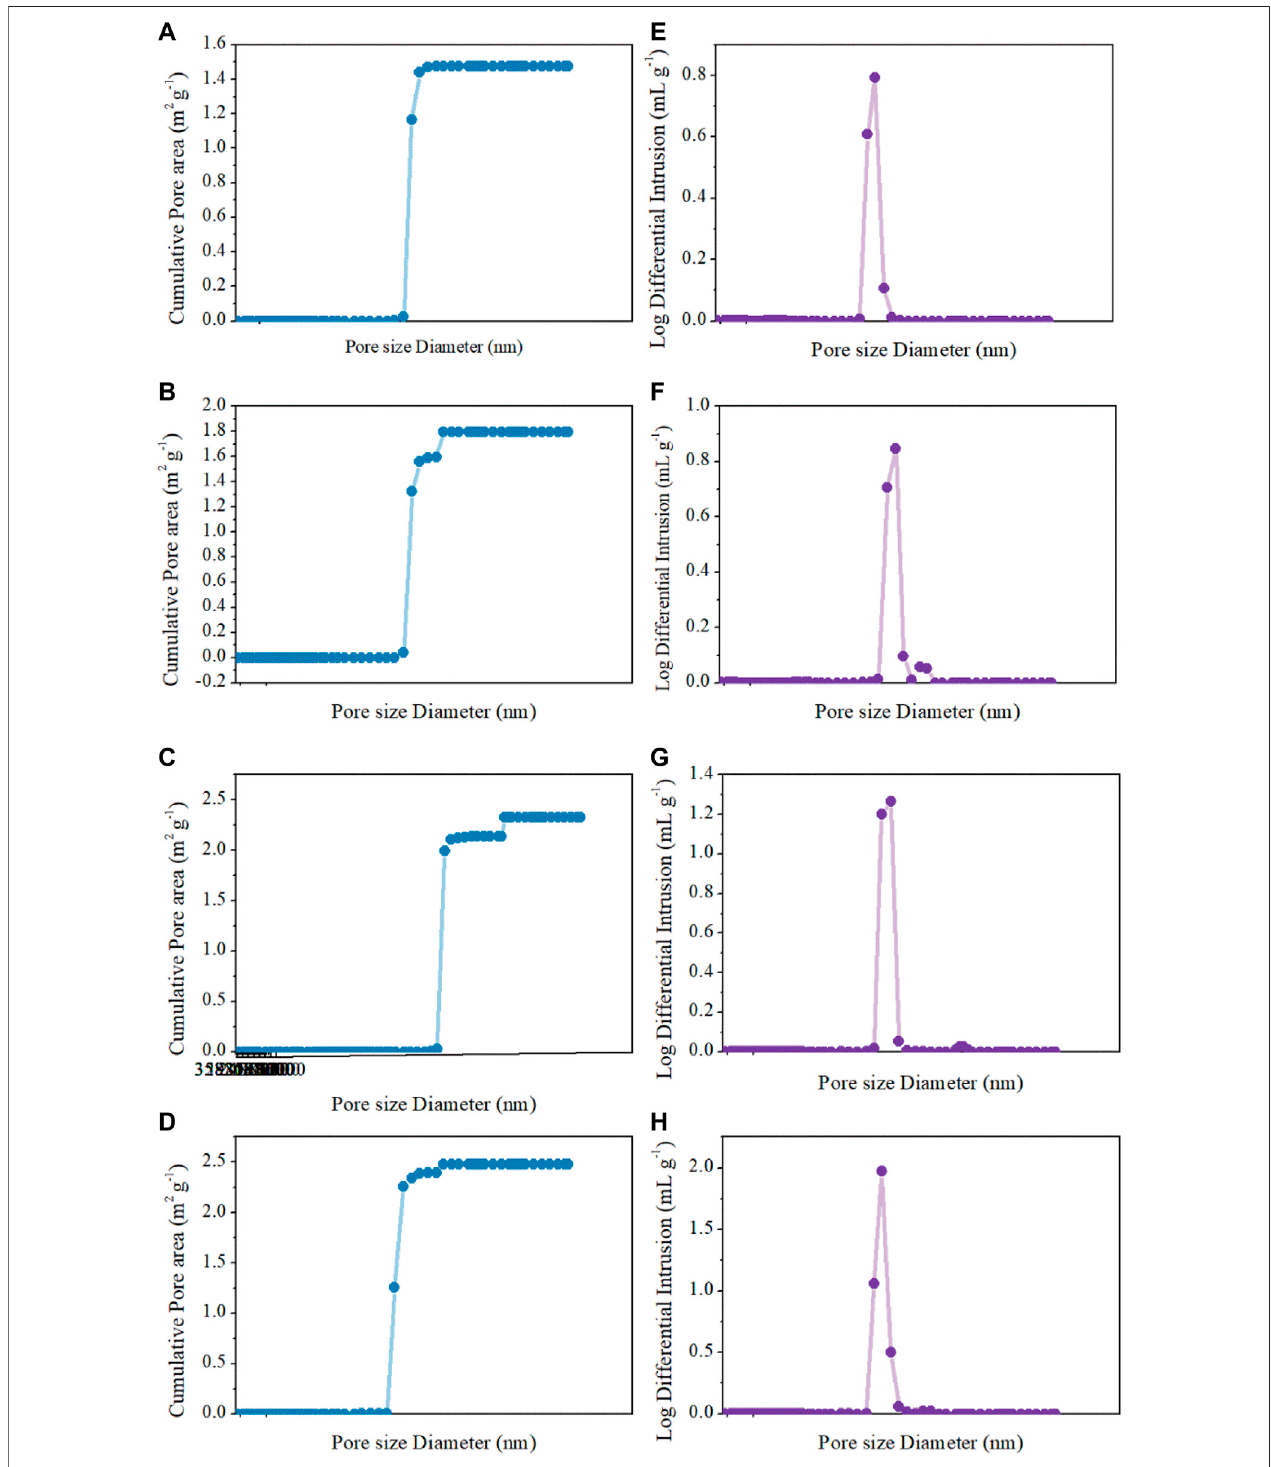
FIGURE 5 | Cumulative pore area and log differential intrusion pore volume of Hg intrusion porosimetry analysis for (A,E) 0wt%, (B,F) 1.5wt%, (C,G) 5wt%, and (D,H) 15wt%.